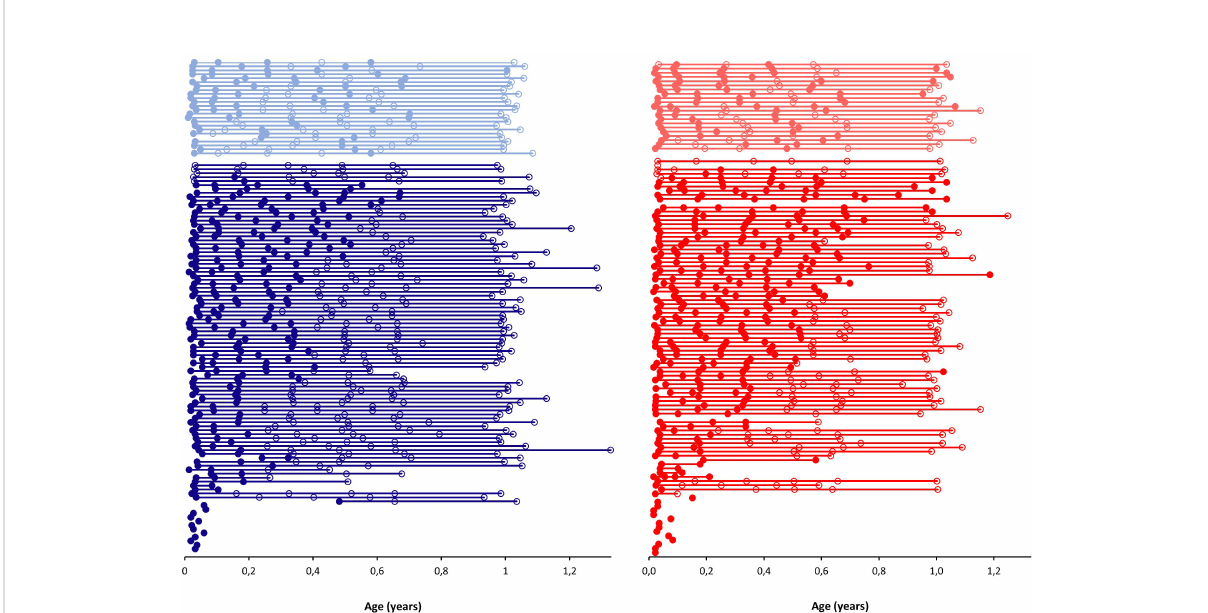
FIGURE 1 The prevalence of palpable breast tissue during the fi rst year of life in boys (blue) and girls (red) according to age (years). Each connected line represents a single child. Circles indicate examinations; open circles are exams without the presence of palpable breast tissue, while closed circles are exams with the presence of palpable breast tissue. Lighter shades indicate children in which transient breast tissue was present, i.e. the appearance, disappearance and reappearance of breast tissue at consecutive